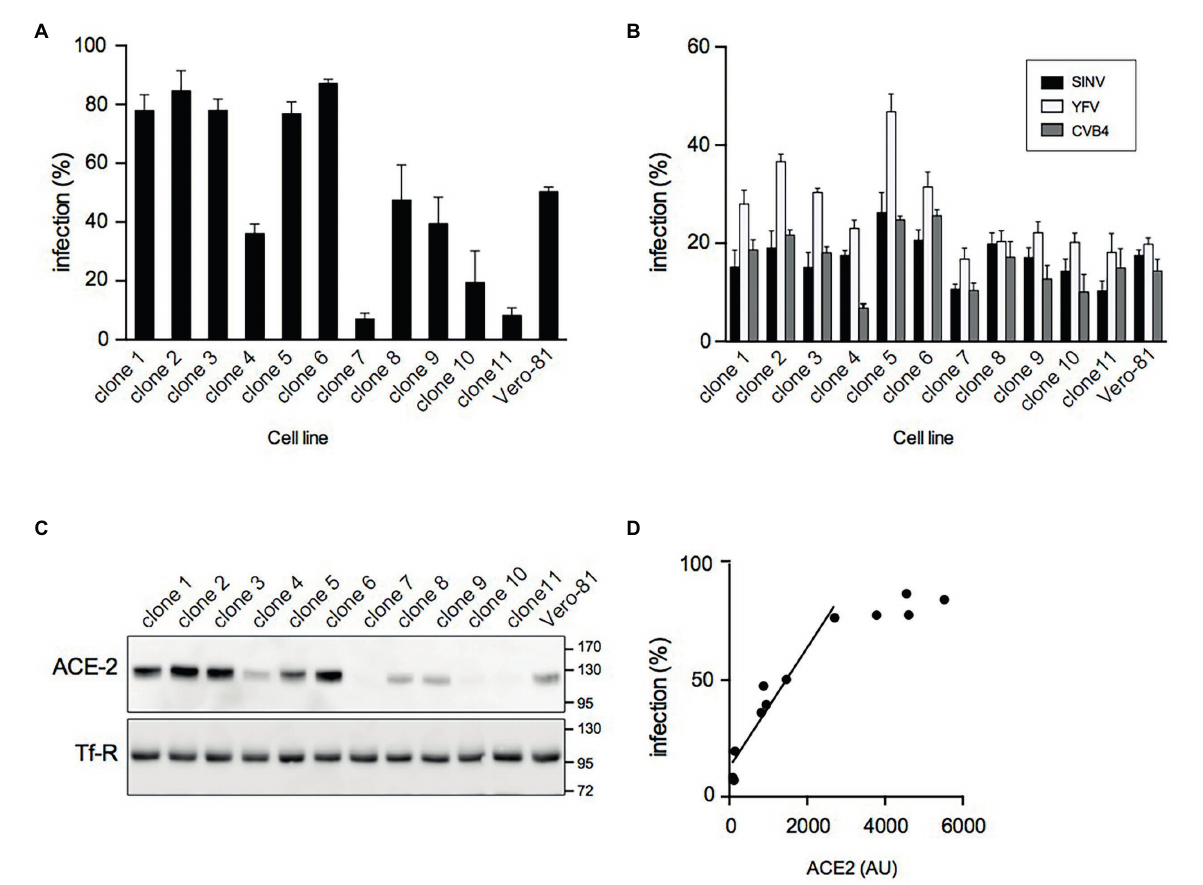
FIGURE 1 Isolation of highly susceptible Vero-81-derived cells. (A) Clonal cell lines were derived from Vero-81 by limiting dilution cloning and infected with SARS-CoV-2. The percentage of infection was measured with an immunofluorescence assay to dsRNA (mean ± SEM of 3 independent experiments). (B) Isolated clones and parental Vero-81 were infected with Sindbis virus (SINV), yellow fever virus (YFV), or coxsackievirus B4 (CVB4). The percentage of infection was measured with immunofluorescence assays to dsRNA (YVF and CVB4) or to E1 (SIN) (mean ± SD of 6 replicates). (C) Immunoblot analyses of ACE2 and transferrin receptor (Tf-R) expression in isolated clones and parental Vero-81. (D) Scatter plot showing the percentage of infection by SARS-CoV-2 as a function of ACE2 expression and the linear regression curve obtained for the clones with lower ACE2 expression levels. AU, arbitrary